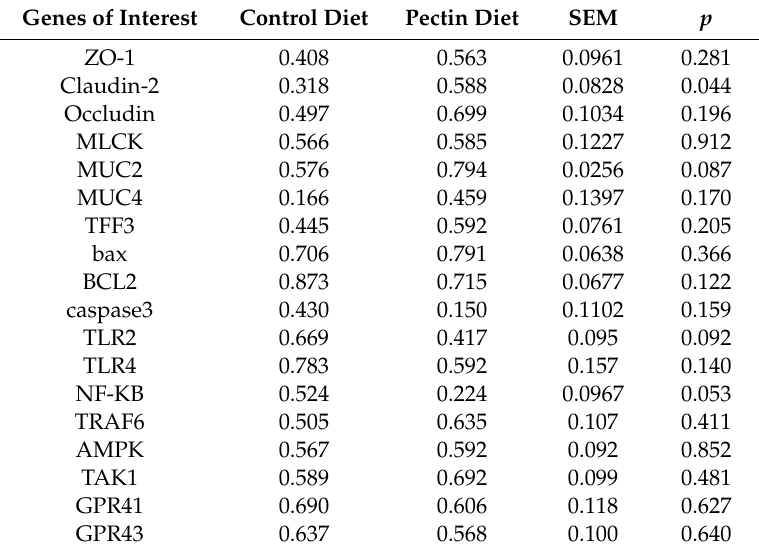
Table 1. Relative expression of genes related to luminal defense, barrier function, apoptosis and the innate immune signaling cascade in the ileum of pigs fed either the control (CON) or pectin (PEC) diet. (Mean values with their standard errors; n = 6 / diet).